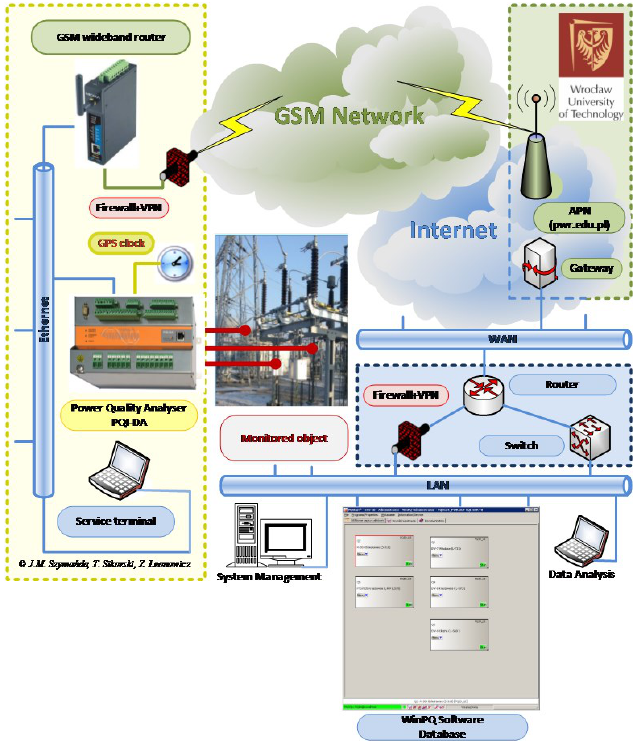
Fig. 1. Functional diagram of the wide-area PQ monitoring system [4,